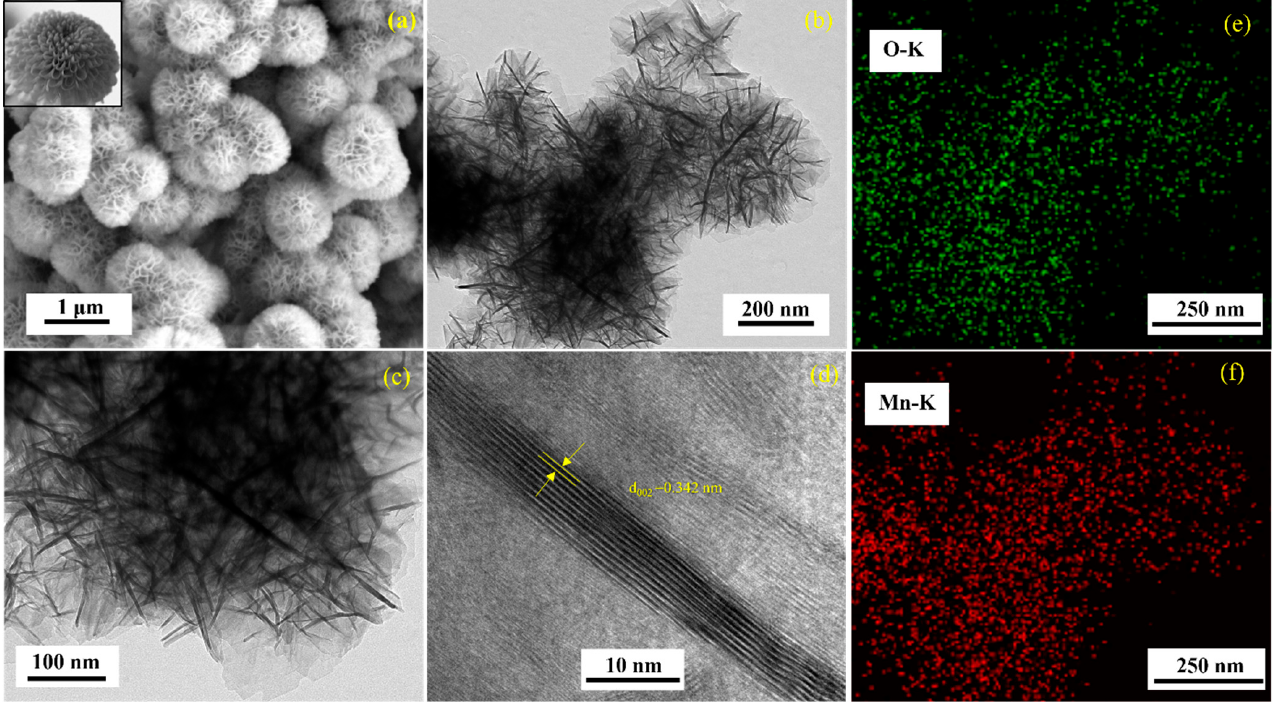
Figure 4. Morphological characterizations: ( a ) FE-SEM image; ( b , c ) FE-TEM images at different magnifications; ( d ) HR-TEM image; ( e , f ) representative EDX mapping images of δ− MnO 2 sample.